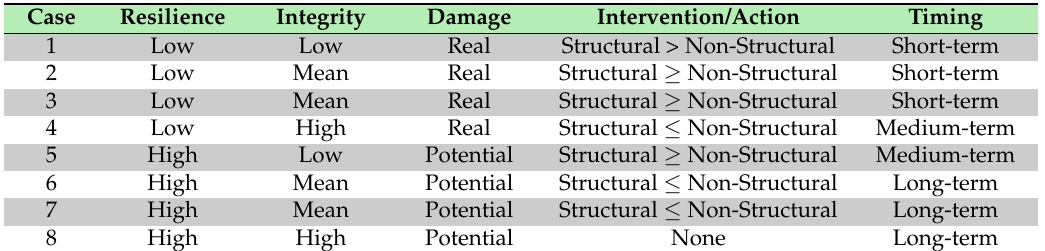
Table 5. Intervention/action typology according to resilience and integrity